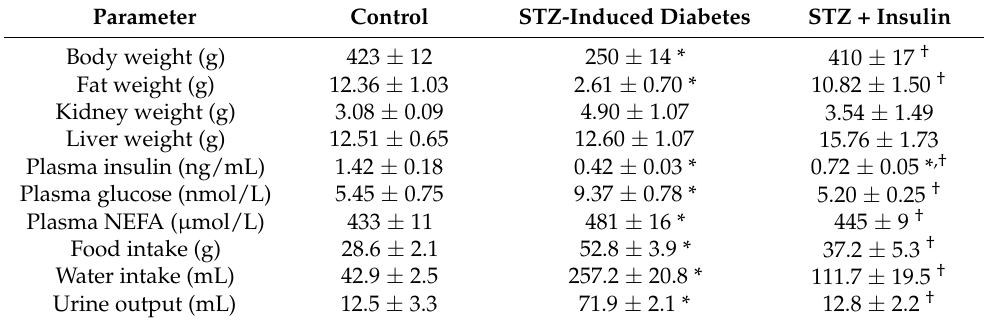
Table 1. TheeffectsofSTZ-induceddiabetesandinsulintreatmentonphysicalandmetaboliccharacteristics.